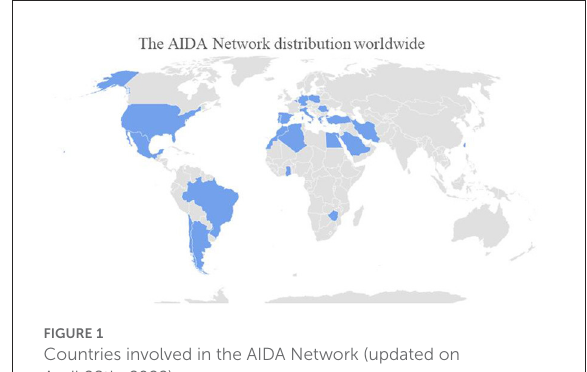
FIGURE1 Countries involved in the AIDA Network (updated on April 28th,